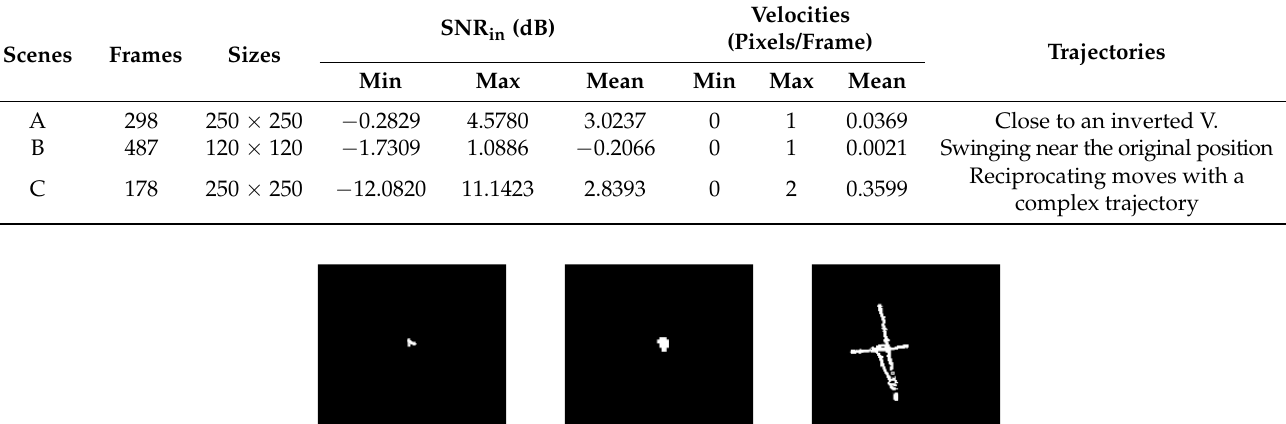
Figure 7. The target movement tracks of scenes A, B, and